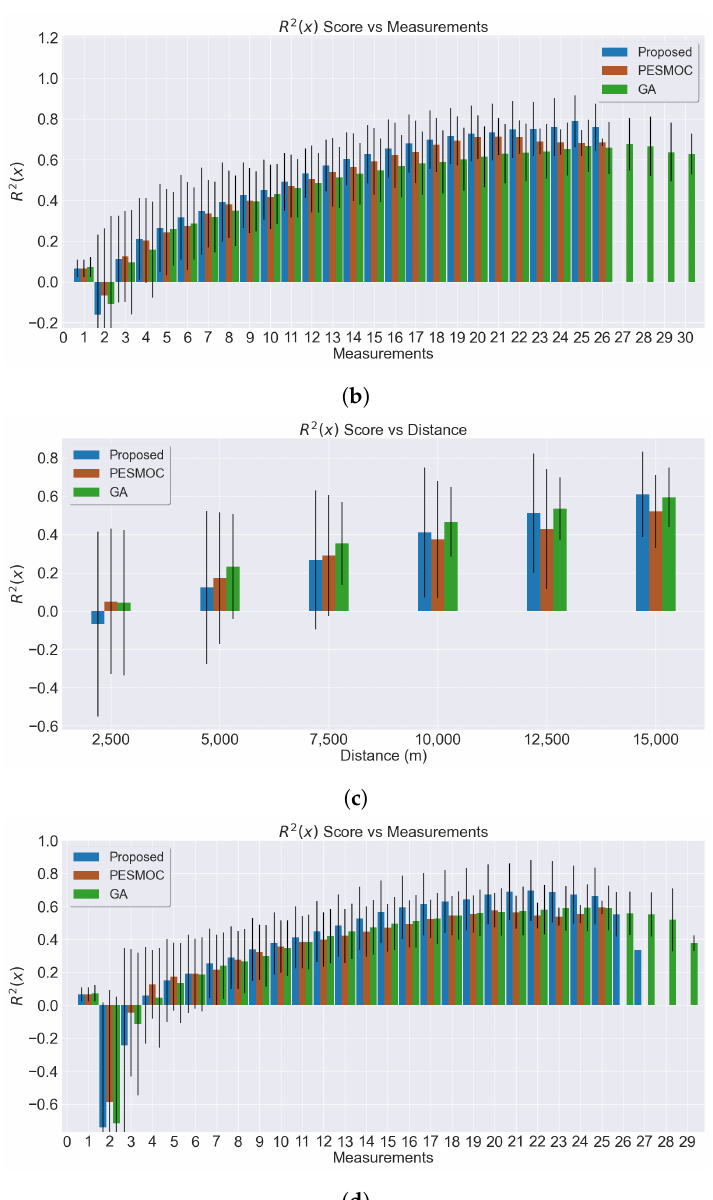
Figure 8. Results for R2 score using three methods. The proposed MEBO approach (blue) is always better when compared with the distance traveled or number of measurements. ( a ) R2S comparison according to the distance traveled and noiseless observations. ( b ) R2S comparison according to the number of noiseless measurements performed. ( c ) R2S comparison according to the distance traveled, with noisy observations. ( d ) R2S comparison according to the number of noisy measurements per-